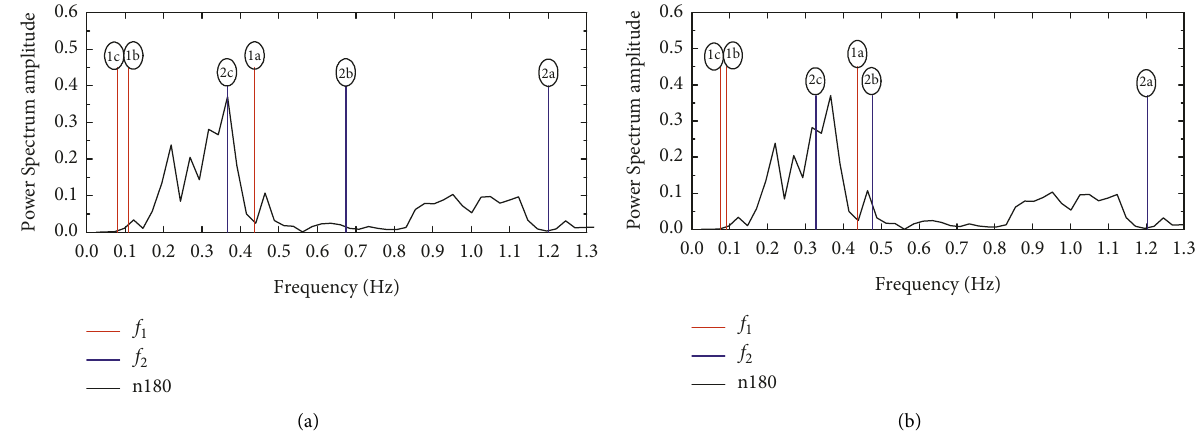
Figure 15: (a) The power spectrum of the record n180 and main natural frequencies of the uncontrolled structure (1a, 2a indicate elastic structure; 1b, 2b indicate the structural second to third storeys of yield; 1c, 2c indicate the structural second to fifth storeys yield); (b) the power spectrum of the record n180 and main natural frequencies of the structure with VDs (1a, 2a indicate elastic structure; 1b, 2b indicate the structural yield of the second to fourth storeys; 1c, 2c indicate the structural first to fifth storeys yield). F 1 and f 2 are the first and second natural frequencies,